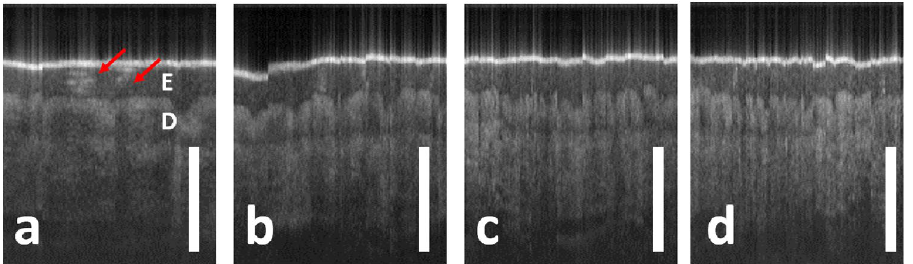
Figure 5. 2D sfOCT images obtained by manually scanning the probe the skin at the index finger, at different lateral sampling intervals. δ x = 10 µ m ( a ), 20 µ m ( b ), 30 µ m ( c ) and 40 µ m ( d ). Epidermis (E) and dermis (D) are labeled in ( a ), with a clear distinction between the two layers. The spiral structure of sweat ducts is visible as a bright structure in ( a ) (red arrows).